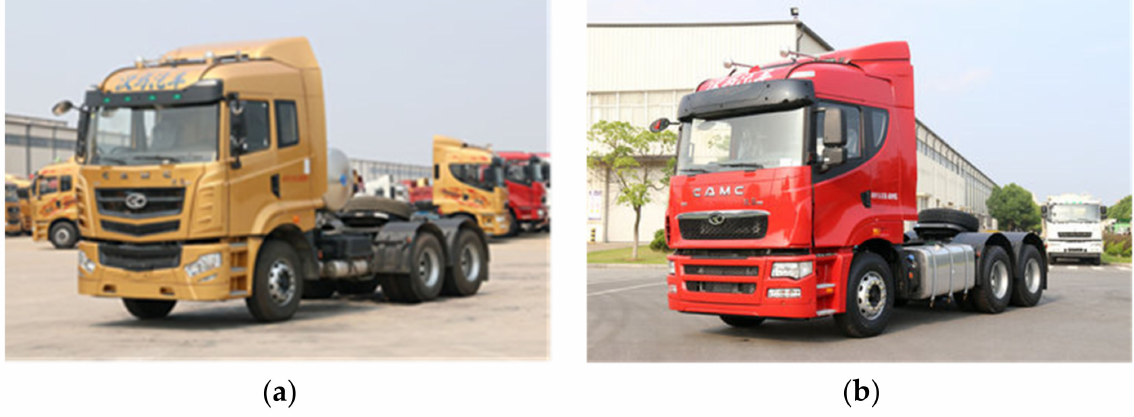
Figure 2. The selected tractor-trailers for comparison: ( a ) LNG tractor-trailer (HN4250NGX41C9M5); ( b ) Diesel tractor-trailer